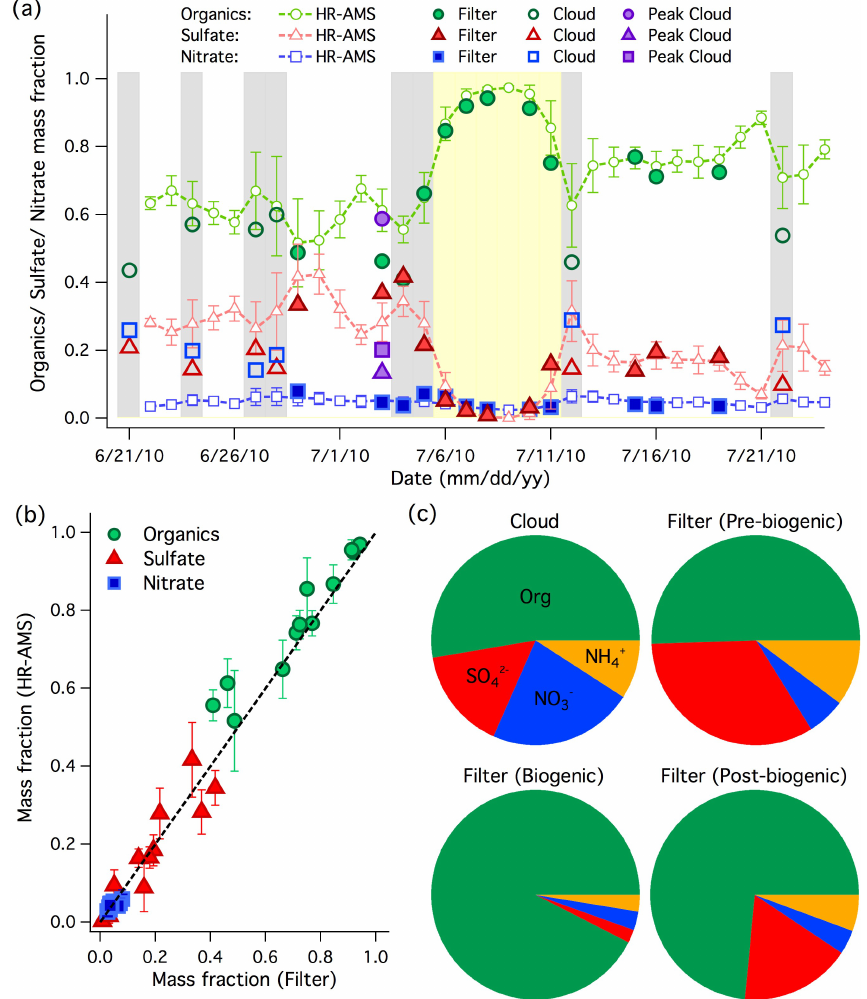
Fig. 1. (a) Chemical composition (sulfate, nitrate, and organics mass fraction) profile of ambient aerosol measured by online HR-AMS, aerosol filter samples at RN, and cloud water samples collected at both RN and peak sites. The biogenic episode is indicated by the yellow shaded region (6–11 July). The in-cloud days at RN are indicated by the grey shaded regions. (b) Correlations between chemical compositions of ambient aerosol measured by online HR-AMS at RN and those of re-aerosolized filter aerosol extracts at the same site. (c) Average chemical compositions of cloud water and water-soluble fraction of aerosol filter samples collected during the pre-biogenic, biogenic and post-biogenic periods at